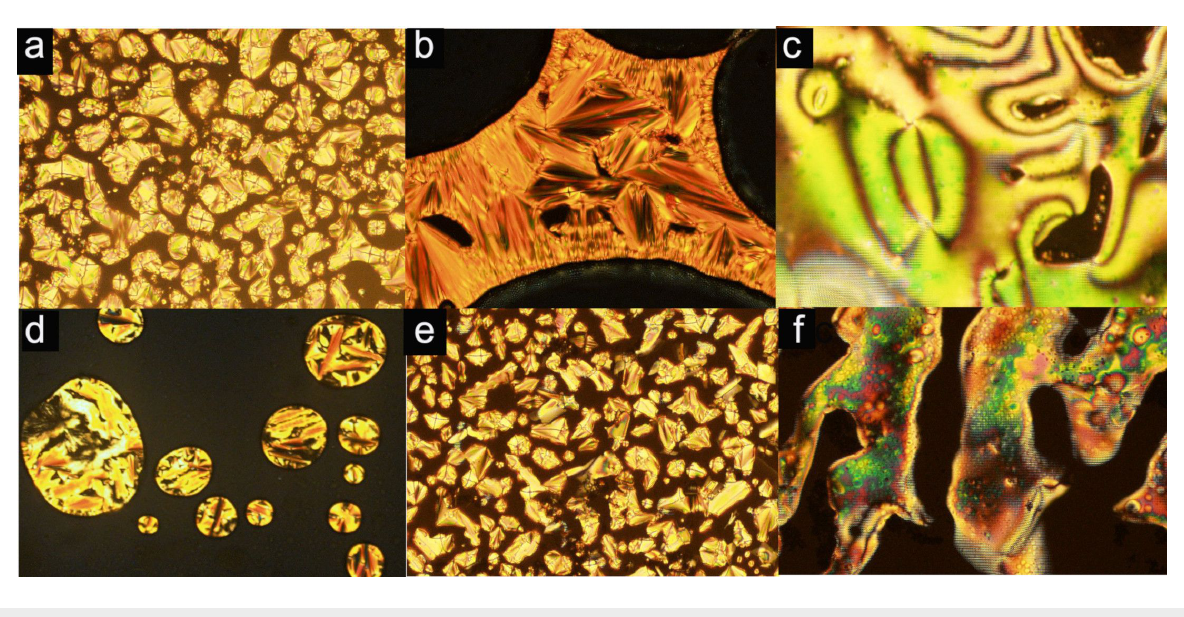
Figure 1: Optical textures observed on POM for thioureas 17a (a), 17b (b), 18a (c), 18b (d) and 18c (e,f). All images were obtained upon cooling from the isotropic phase with the exception of (b). The “grid aspect” found in images (c) and (f) is an artifact due to the fast movement of the fluid mesophase.